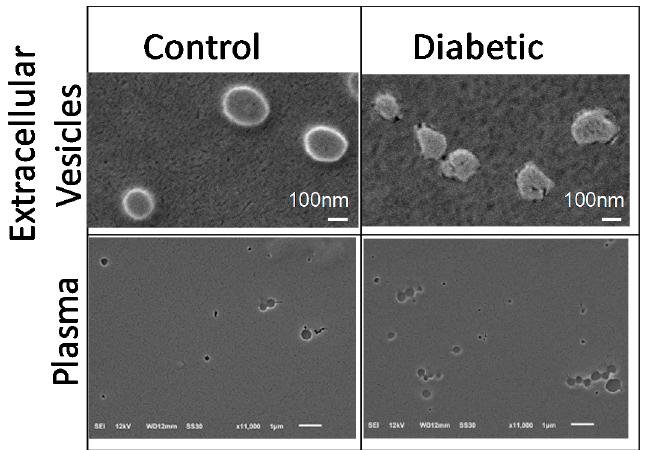
Figure 5. Scanning electron microscopy (SEM) of rat plasma and ultracentrifugation isolated extracellular vesicles. Extracellular vesicles (top) or plasma (bottom) were isolated from (left) control or (right) diabetic rats after seven weeks of STZ diabetes. Cholesterol crystals were not visible, via SEM, in isolated extracellular vesicle or plasma samples acquired from either control or diabetic rats.